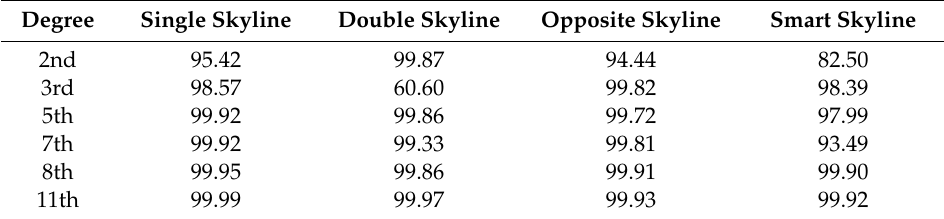
Table 10. Polynomial curve-fitting on the synthetic Dataset I.